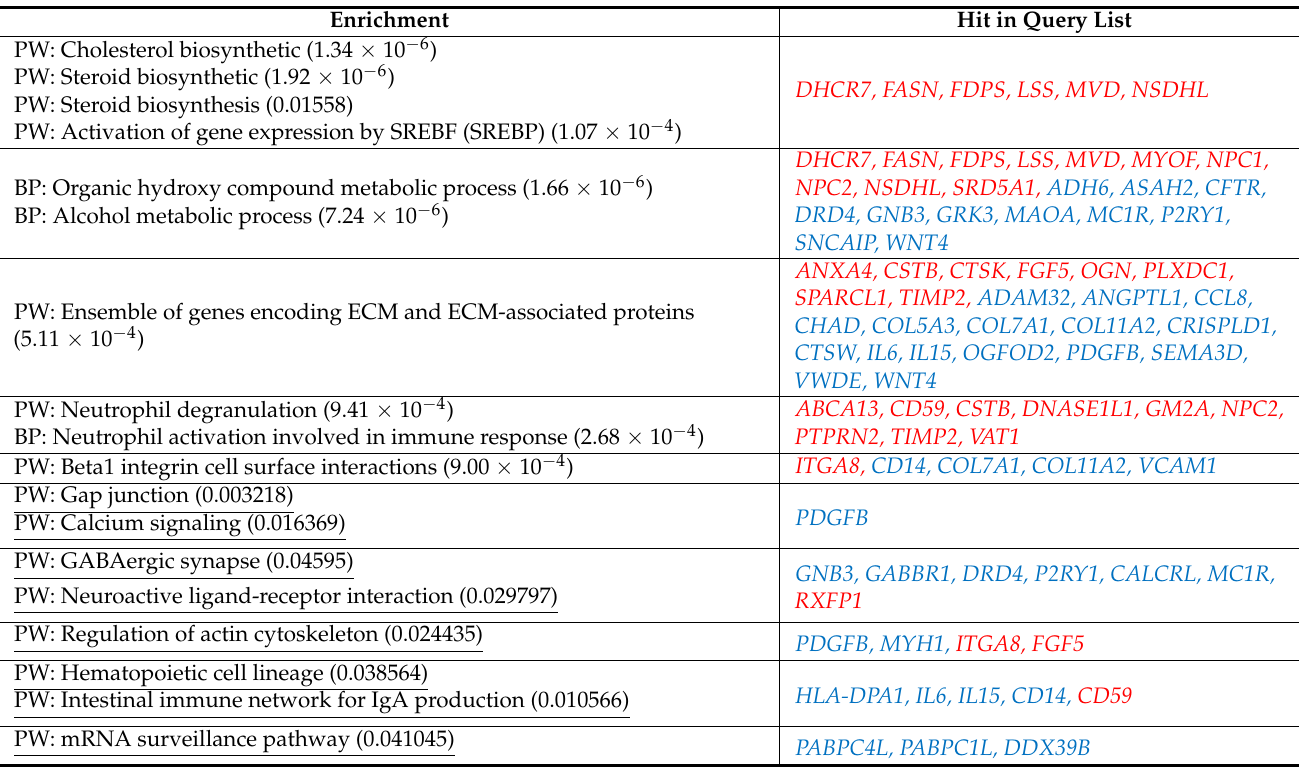
Table 3. Functional enrichment for the comparison “AA-SScL vs. EA-SScL.” Shown here are pathways (PW), biological process (BP), and molecular function (MF) ontologies with the lowest p -value and the most hit genes in the query list returned by ToppFun and iPathwayGuide (underlined). Red: upregulated genes, blue: downregulated genes. The p -values are shown in parentheses. Enrichment Hit in Query